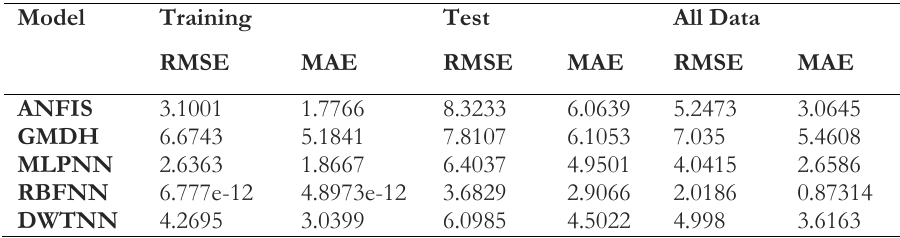
Table 2. The performance of the employed models.